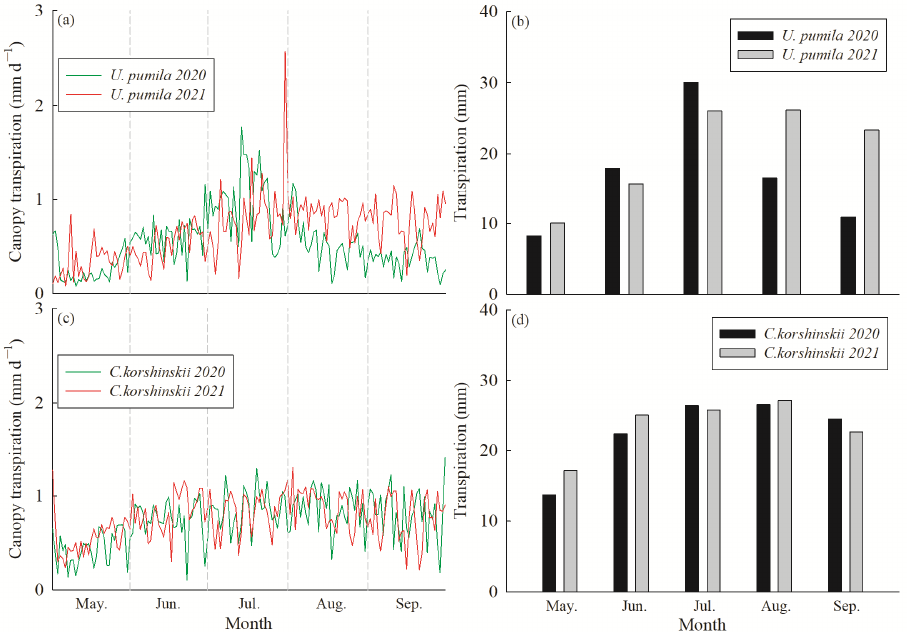
Figure 3. Daily precipitation and volumetric soil water content (0–100 cm) from May 1 to September 30 in ( a ) U. pumila and ( b ) C. korshinskii.